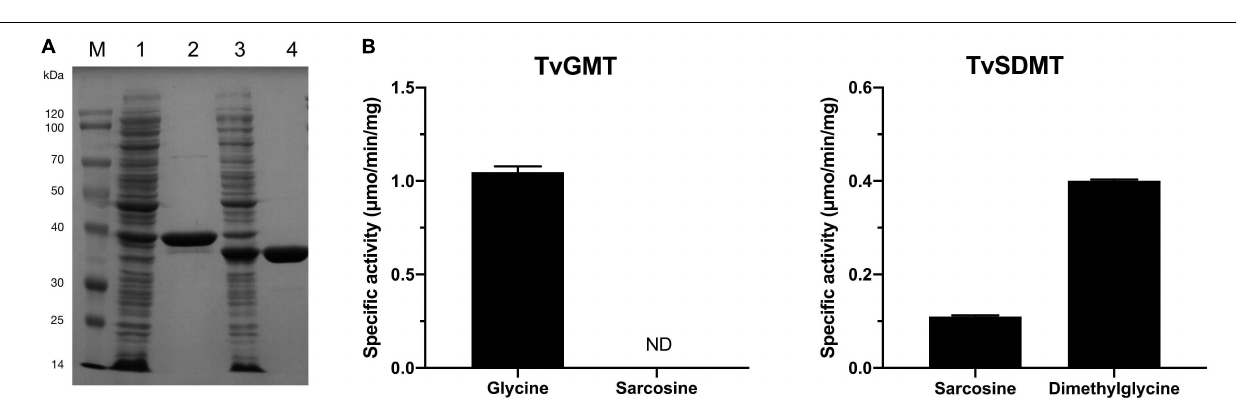
FIGURE 5 | Glycine N -methyltransferase (TvGMT) and sarcosine dimethylglycine N -methyltransferase (TvSDMT) overexpressed and purified from E. coli convert glycine to glycine betaine by sequentially transferring three methyl groups to glycine. (A) SDS-PAGE analysis of TvGMT and TvSDMT. Lane M, protein marker; Lane 1, crude extract of TvGMT; Lane 2, purified TvGMT; Lane 3, crude extract of TvSDMT; Lane 4, purified TvSDMT. (B) Specific activities of TvGMT and TvSDMT using glycine, sarcosine, and dimethylglycine as substrates, respectively. Data are the average of three biological replicates and the error bars represent the